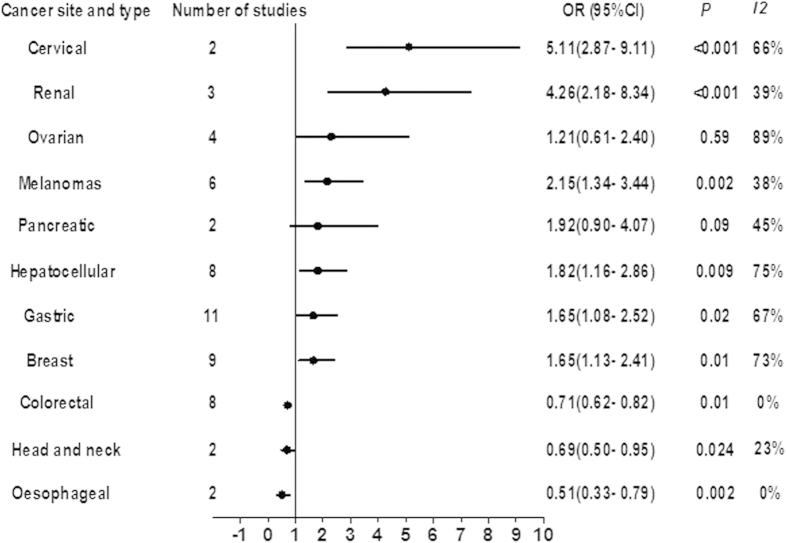
Summary risk estimates of overall survival (OS) by cancer sites.